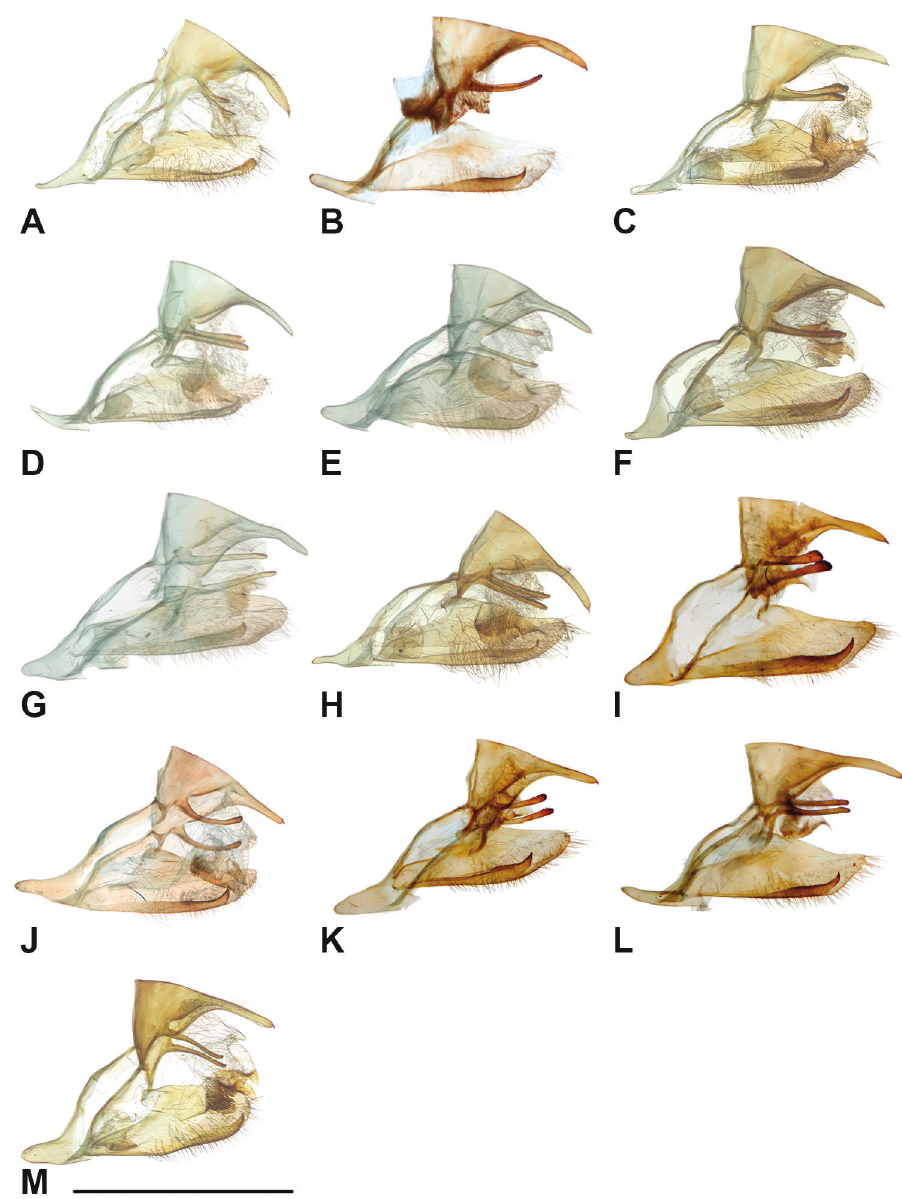
Figure 26. A cybele cybele NHM Indonesia: North Maluku, Halmahera B cumaea toliana MCZ In- donesia: North Sulawesi C hewitsoni meliophila NHM Indonesia: Maluku, Kisar D mimalon mimalon NHM Indonesia: Sulawesi E hicetas hicetas NHM Indonesia: Sulawesi F hicetas hicetina NHM Indo- nesia: Sulawesi G holofernes NHM Papua New Guinea: New Britain H bornemanni NHM Indonesia: Central Sulawesi, Banggai I phrikonis MCZ Indonesia: North Maluku, Sula Regency, Sanana J sangira NMNH Indonesia: North Sulawesi, Sangir island K umbratilis MCZ Indonesia: Papua, Biak L resplen- dens MCZ Indonesia: Central Sulawesi, Palu M singhala NHM Sri